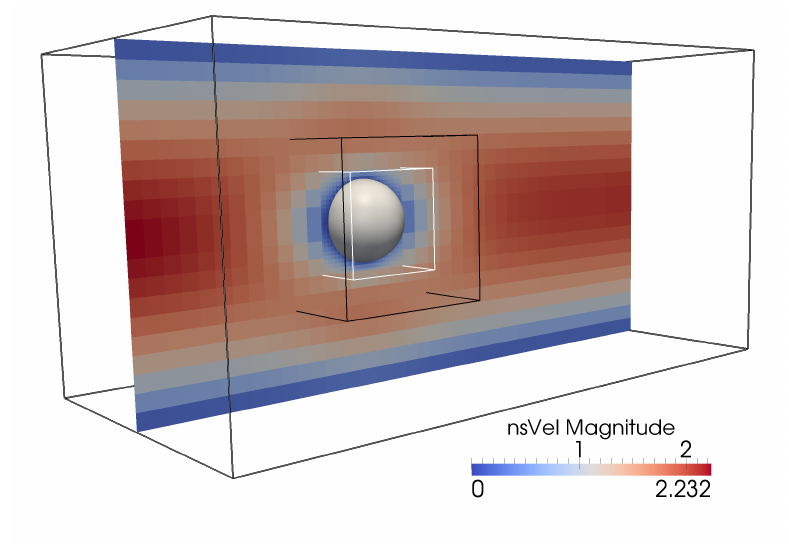
Figure 7. Steady-state velocity field for the LBNS scenario for flow past a spherical obstacle. The inner black-framed box shows the LB simulation domain, the region between inner black- and white-framed box corresponds to the overlap